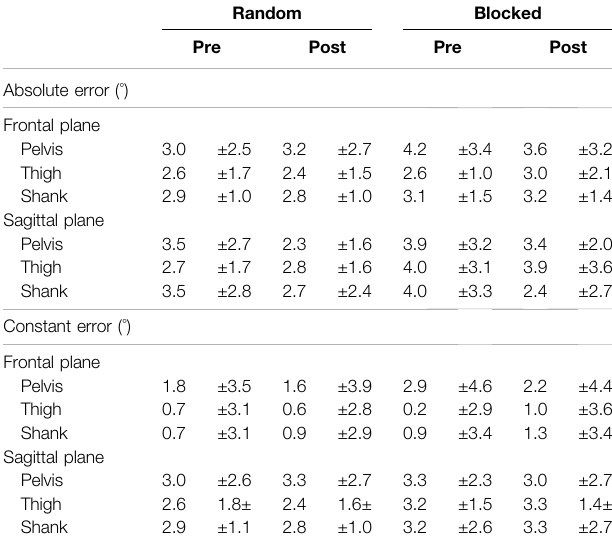
TABLE 2 | Absolute (ignoring directions) and constant (considering directions) error values obtained by quantifying angular deviations from the vertical axis for each segment during the balance perturbation tests. Frontal and sagittal plane values represent angular deviations obtained when participants shifted form tilt surface (ankle inversion and ankle dorsi fl exion, respectively) to fl at